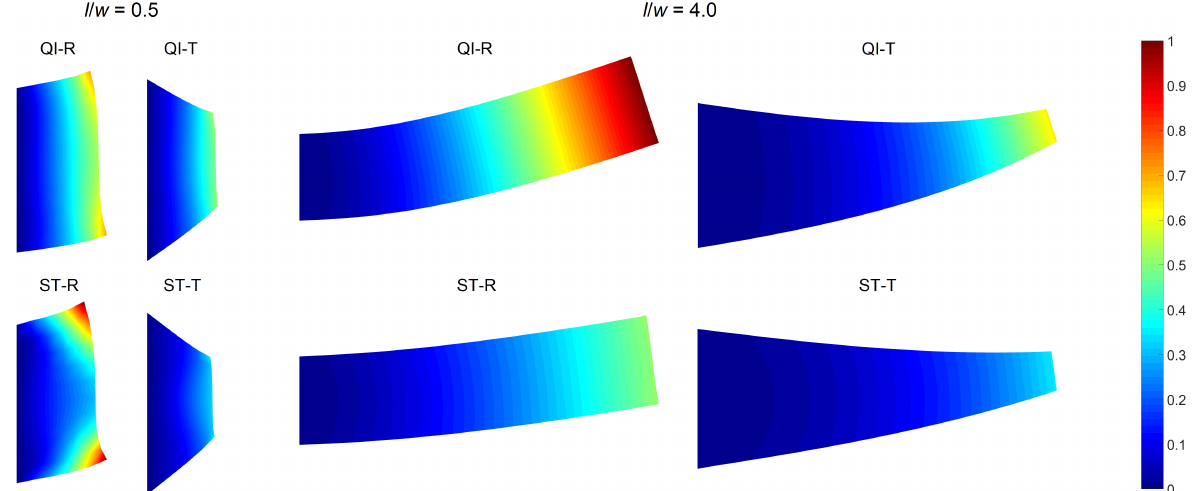
Figure 7. Plate deflection contours for different designs and nominal aspect ratios. The deflection profiles differ significantly with both panel design and aspect